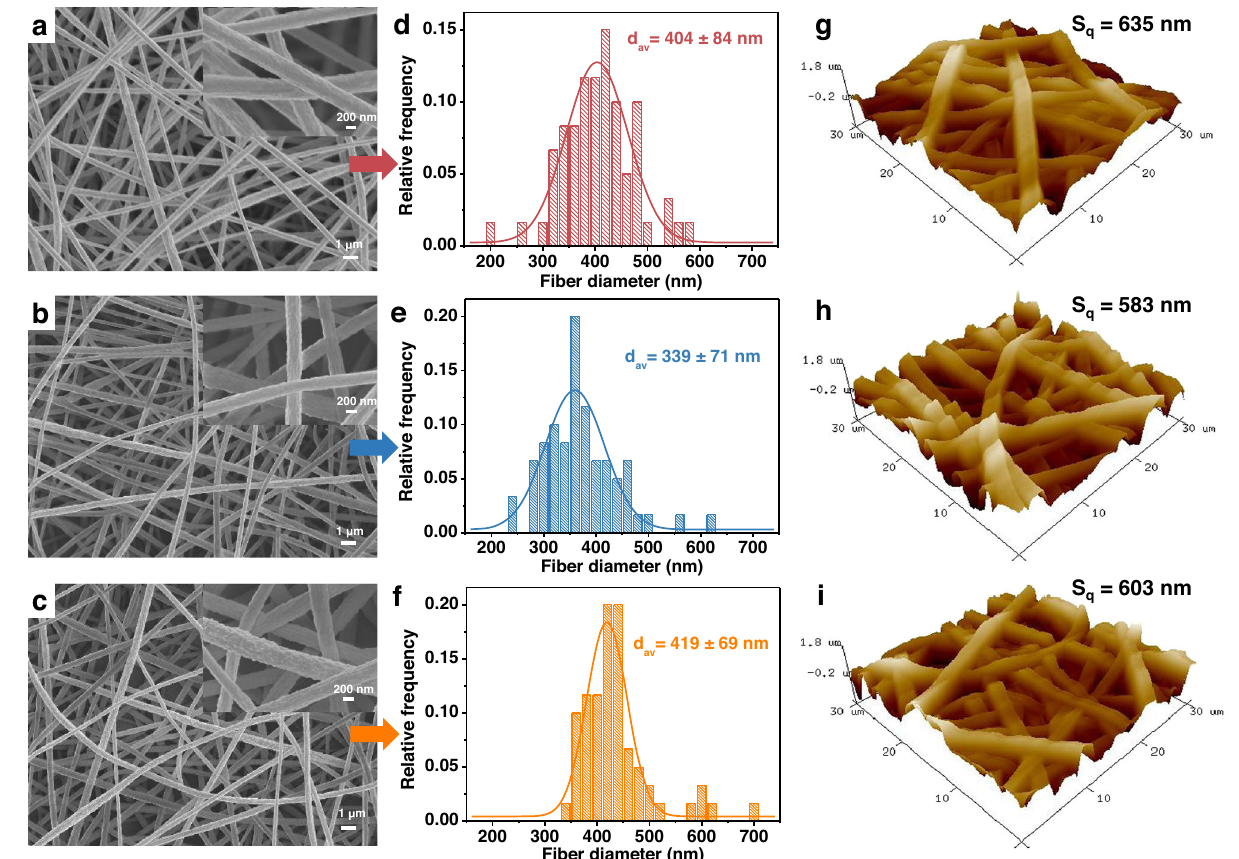
and ( f ) DCCNF-100C; g – i AFM images of ( G ) DCCNF-30C, ( h ) DCCNF-60C, and ( i ) DCCNF-100C, where S q is root mean square roughness.